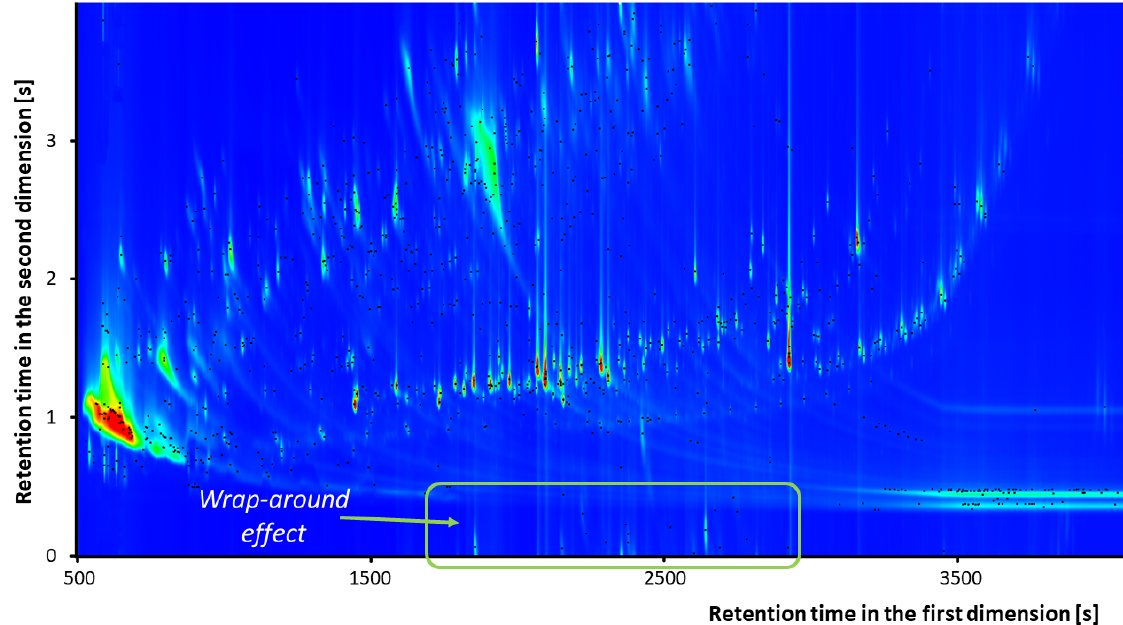
Figure 3. The TIC 2D chromatogram of a real scent sample measured under the conditions described in Section 2.4 on Rxi-5ms (2 + 30 m) and Rxi-17Sil MS (1 m) columns.